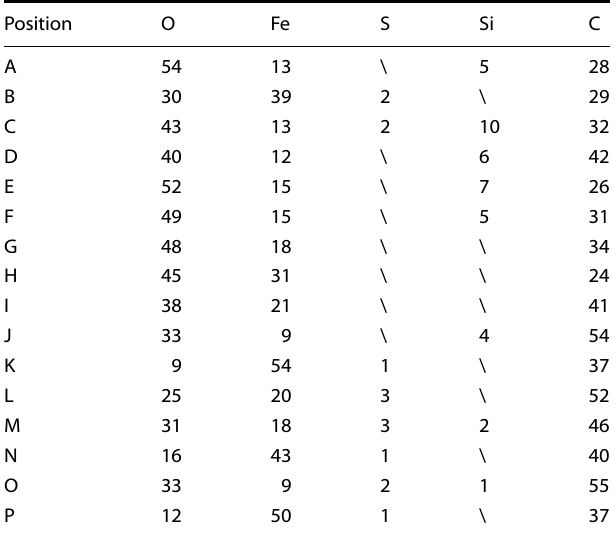
Table 1. EDS results of corrosion products on the surface of BM, HAZ, and WZ for the welded joints